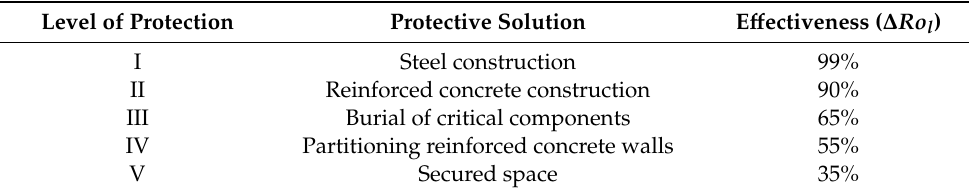
Table 5. Protection Methods for Improving